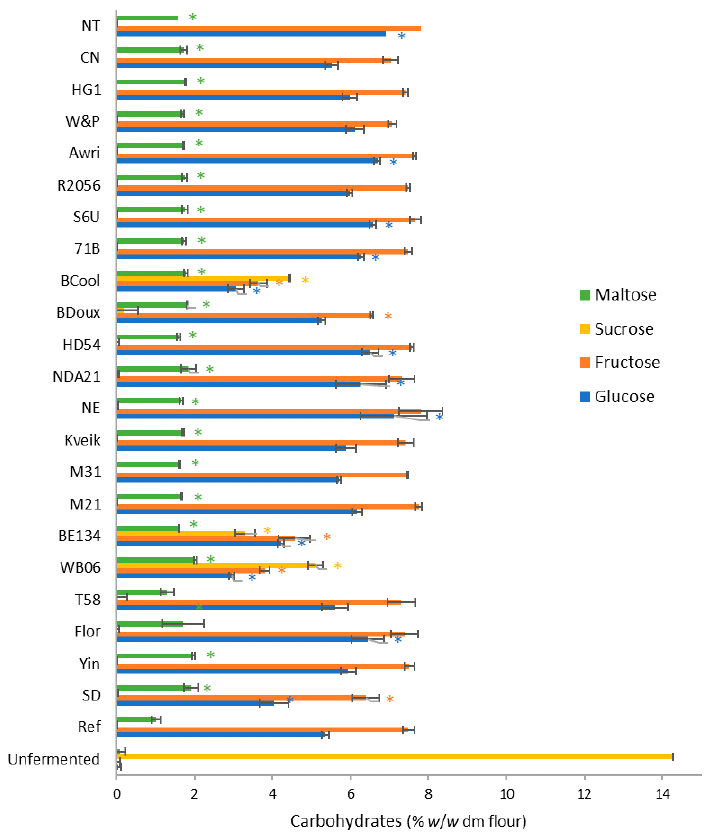
Figure 1. Glucose, fructose, sucrose, and maltose concentrations in sweet doughs (14% sugar, w / w dm flour) made with 23 different yeast strains after a fermentation step of 120 min at 30 °C. Concentrations are expressed on flour dry matter base (% w / w dm flour). The standard deviations result from triplicate measurements. ‘*’ indicates concentrations that were significantly different from the reference (ref) ( p < 0.05).